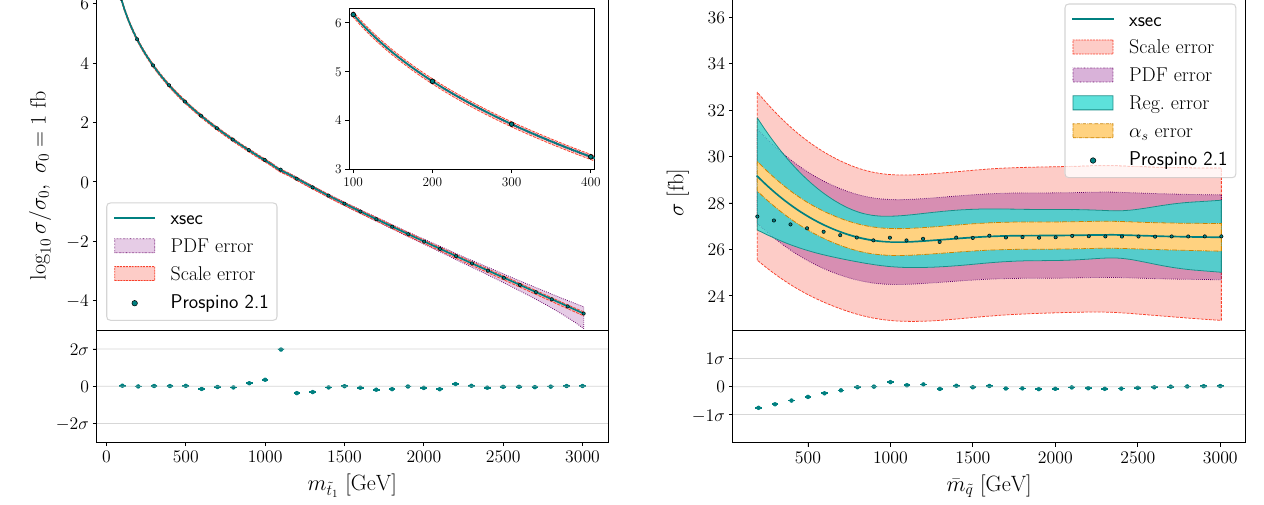
Fig. 17 Stop pair-production cross-section as a function of stop mass. The central-value xsec prediction is shown in light green, the scale error in pink, and the PDF error in violet. The 1 σ α s and regression error bands are too small to be visible. Superimposed on the prediction are the Prospino values (dots). Inset is a close-up of the region at low stop masses